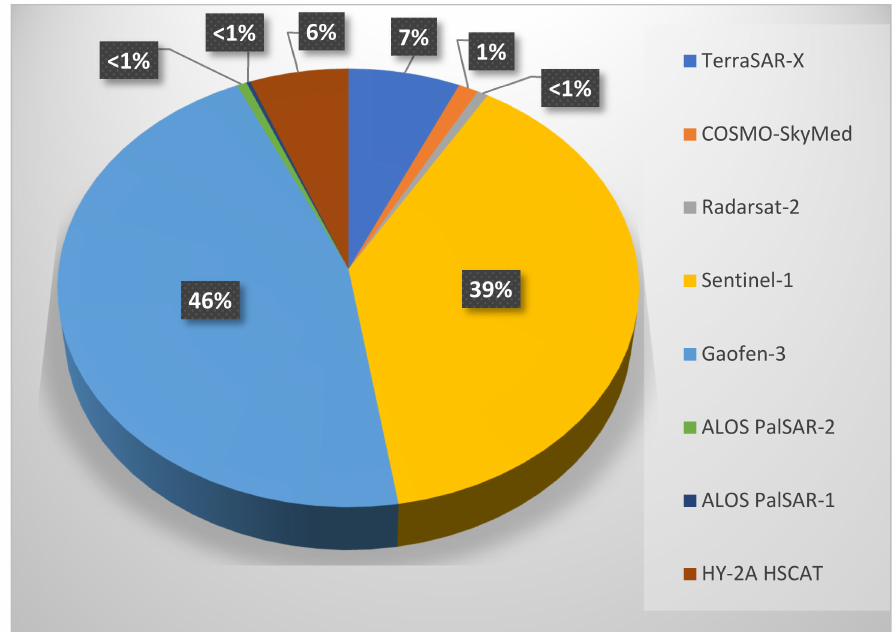
Figure 1. EO data collected by SAR (1561) and scatterometer (99)